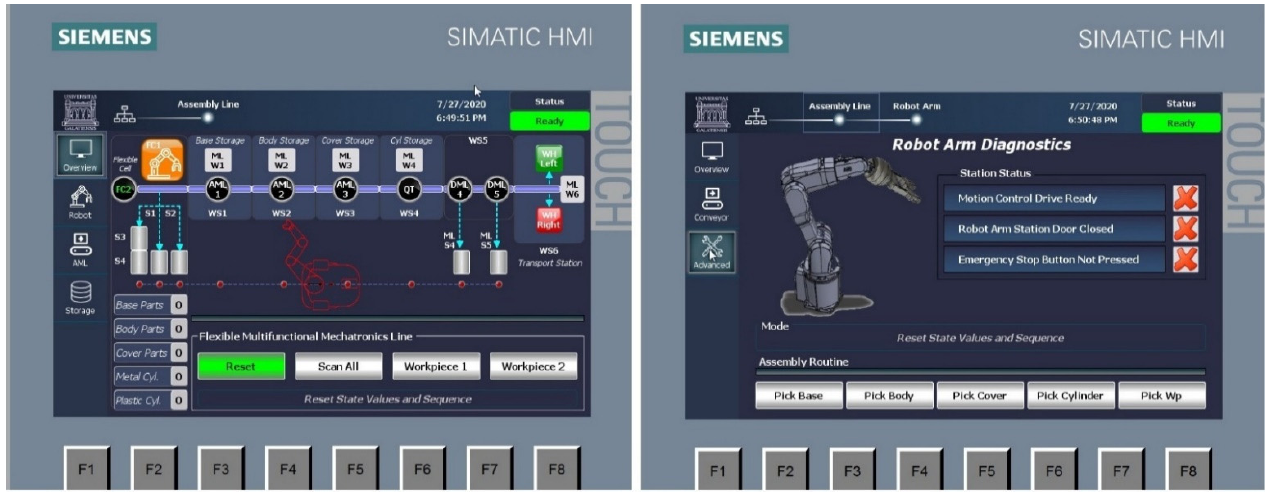
Figure 21. Control and visualization of A/D/RML via Siemens HMI (KTP700).